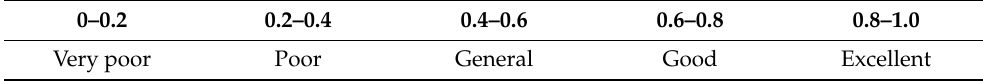
Table 1. Lake ecological status level.